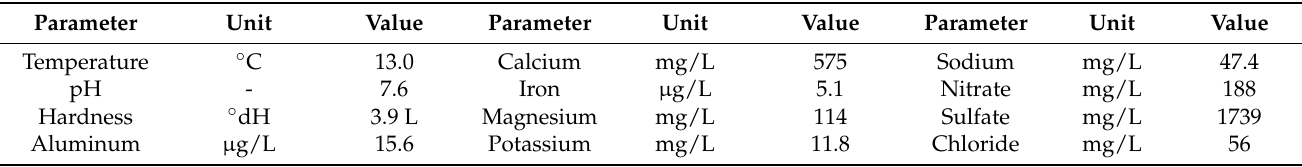
Table 8. Composition of sulfate containing groundwater, taken from anhydrite mine in Hüttenheim, Germany in November